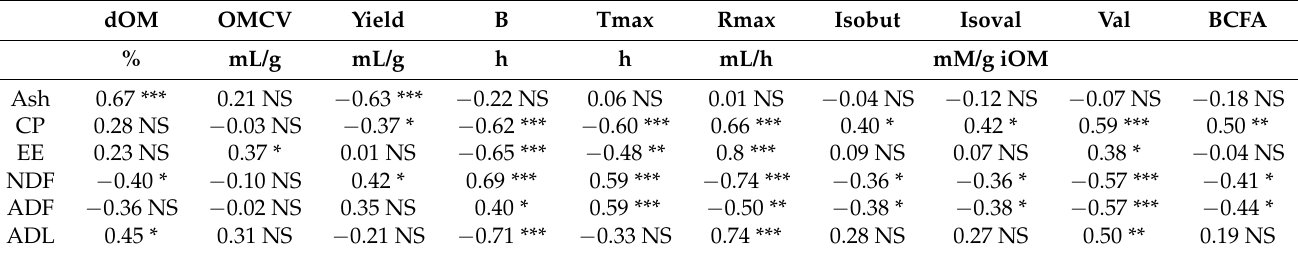
Table 4. Significance of correlation between some chemical parameters and in vitro fermentation data ( n =